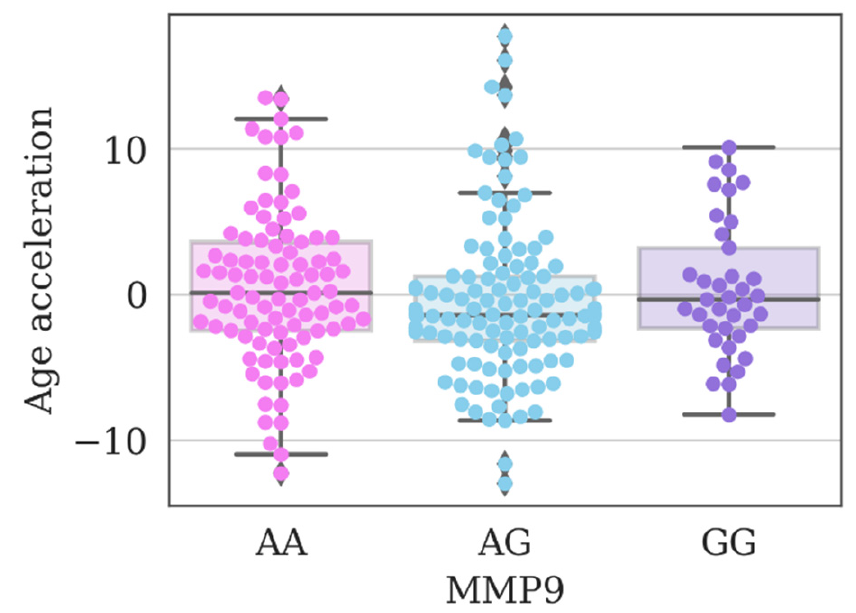
Figure 4. The acceleration value of biological age calculated by the PhenoAge model in the study group of individuals depending on the genotypes of the polymorphism rs17576 of the MMP9 gene. No significant differences at a corrected p -value ( p ) < 0.05 (Kruskal–Wallis test). At the same time, applying the correction for multiple hypothesis testing, we did not